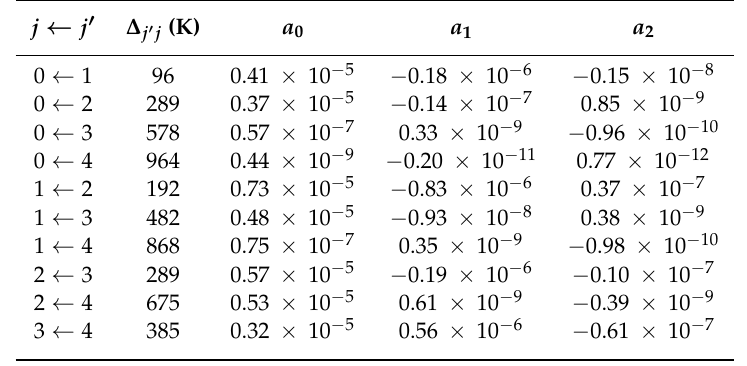
Table 1. Parameters a 0 , a 1 , and a 2 of the polynomial P fit of initial and final rotational states for de-excitation j ← j (cid:48) of HeH + , with j < j (cid:48) . The probabilities ( x ) for the opposite (excitation) process, j → j (cid:48) , are obtained from P fit P fit j (cid:48) j the factor ( 2 j (cid:48) + 1 ) / ( 2 j + 1 ) (see Equation (7)). For convenience, we also specify (the second column) the threshold energy ∆ j (cid:48) j in units of temperature (K) for the excitation process of the corresponding pair. For the de-excitation processes, ∆ j (cid:48) j =